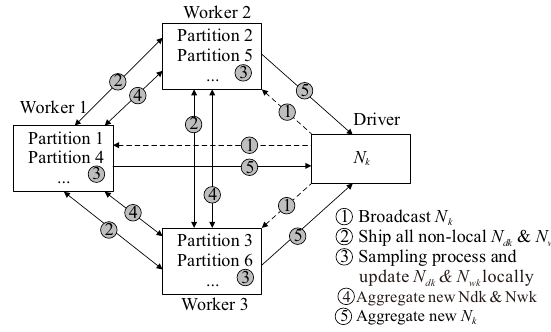
Fig. 2 Distributed LDA workflow in an iteration.